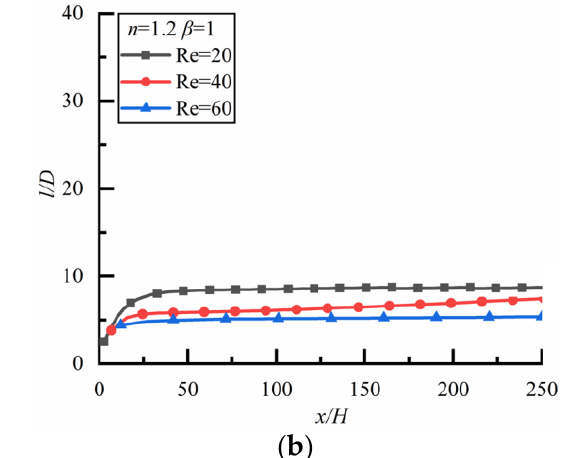
Figure 7. Changes of l/D along flow direction for different Re in a Newtonian fluid.